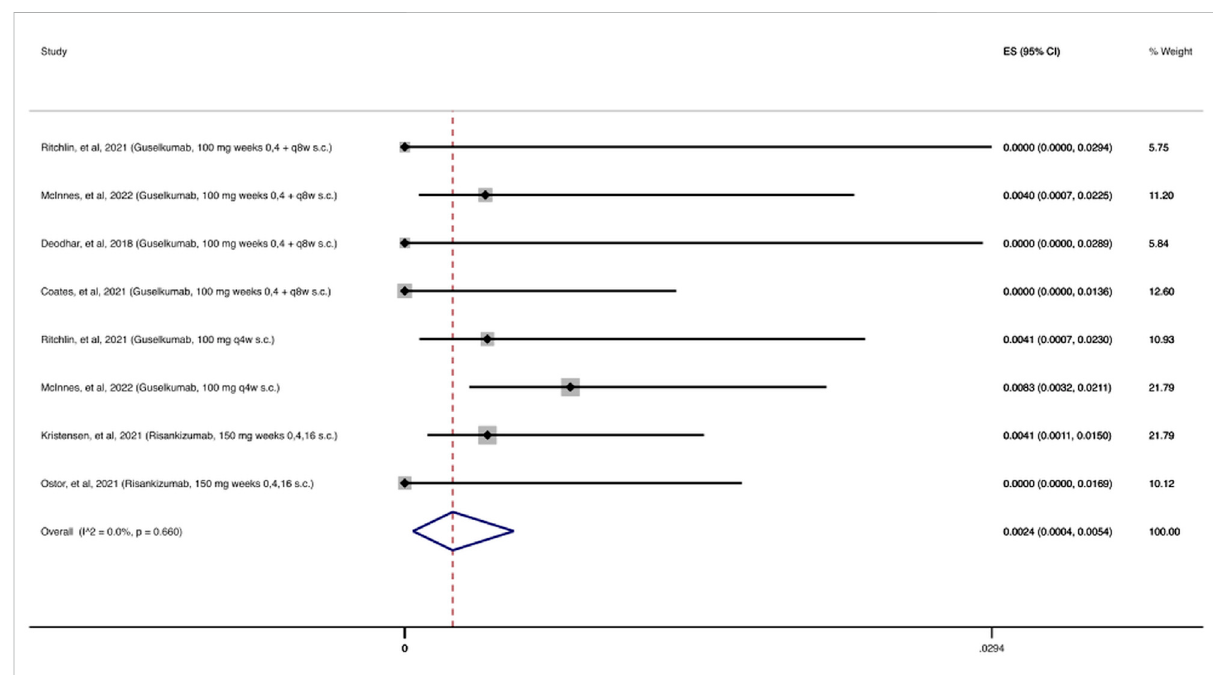
FIGURE 4 Opportunisticinfectionscumulativeincidenceforanti-IL-23duringRCTsandtheirextensionperiods.Individualandcombinedestimatesofthe cumulative incidence of opportunistic infections for patients treated with anti-IL-23 with 95% con fi dence intervals. ES: Effect Size (Cumulative